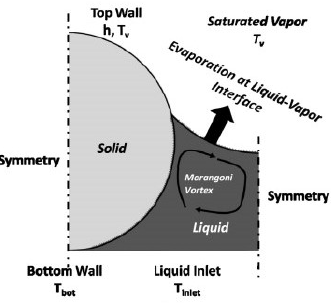
Figure 13. Thin film curved liquid surface at the solid–liquid interface and its boundary conditions conditions [74].